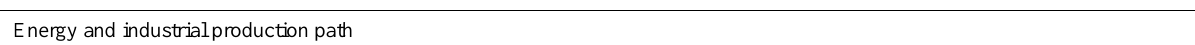
Table 1. Basic principles and assumptions of energy path and emission control strategies for scenarios in this work. Scenarios